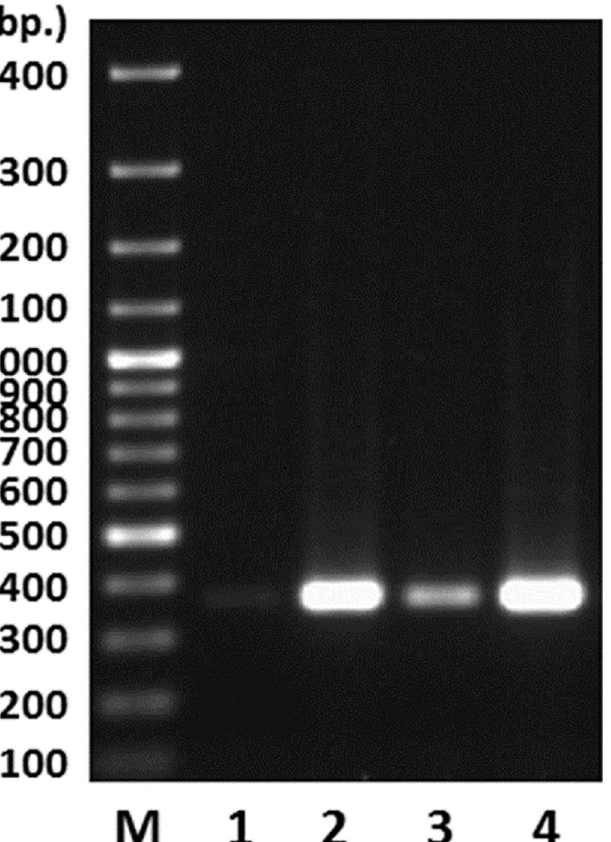
Fig 5. Agarose gel electrophoresis of the PCR amplicons obtained from genomic DNA of the fully and semiejected ascospores of C . sinensis using the Samsoniella hepiali -specific Php4/Php6 primers. Lane M shows the molecular weight standard. Lanes 1 and 3 display the amplicon moieties amplified from the genomic DNA of the fully ejected ascospores. Lanes 2 and 4 show the amplicons amplified from the genomic DNA of the semiejected ascospores. species-specific primer pairs ( cf . Table 1): Prp2/Prp5 for G . pannorum (JF320819) and P . roseus